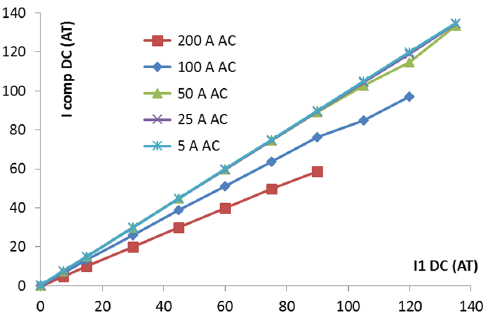
Figure 7. Closed-loop response to DC current for high impedance in the primary circuit. The parameter is the measured AC current I 1 .